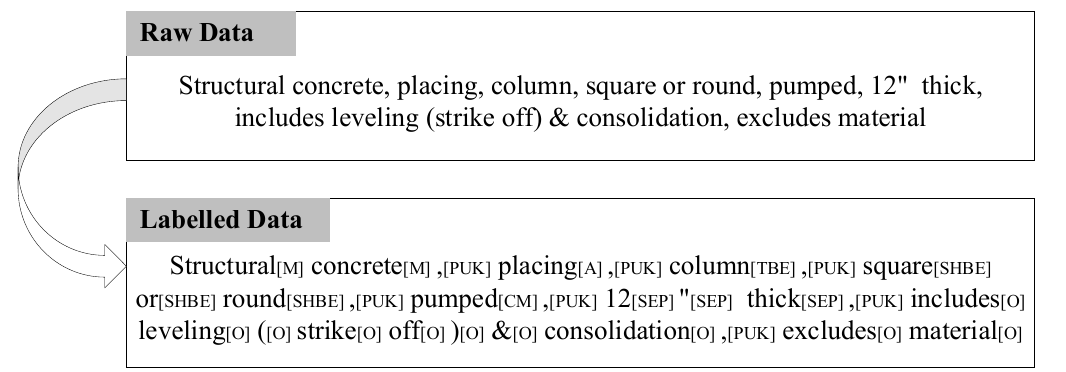
Figure 11. Example of labeled data. Table 4. F1 scores of four NER algorithms and combined algorithms.